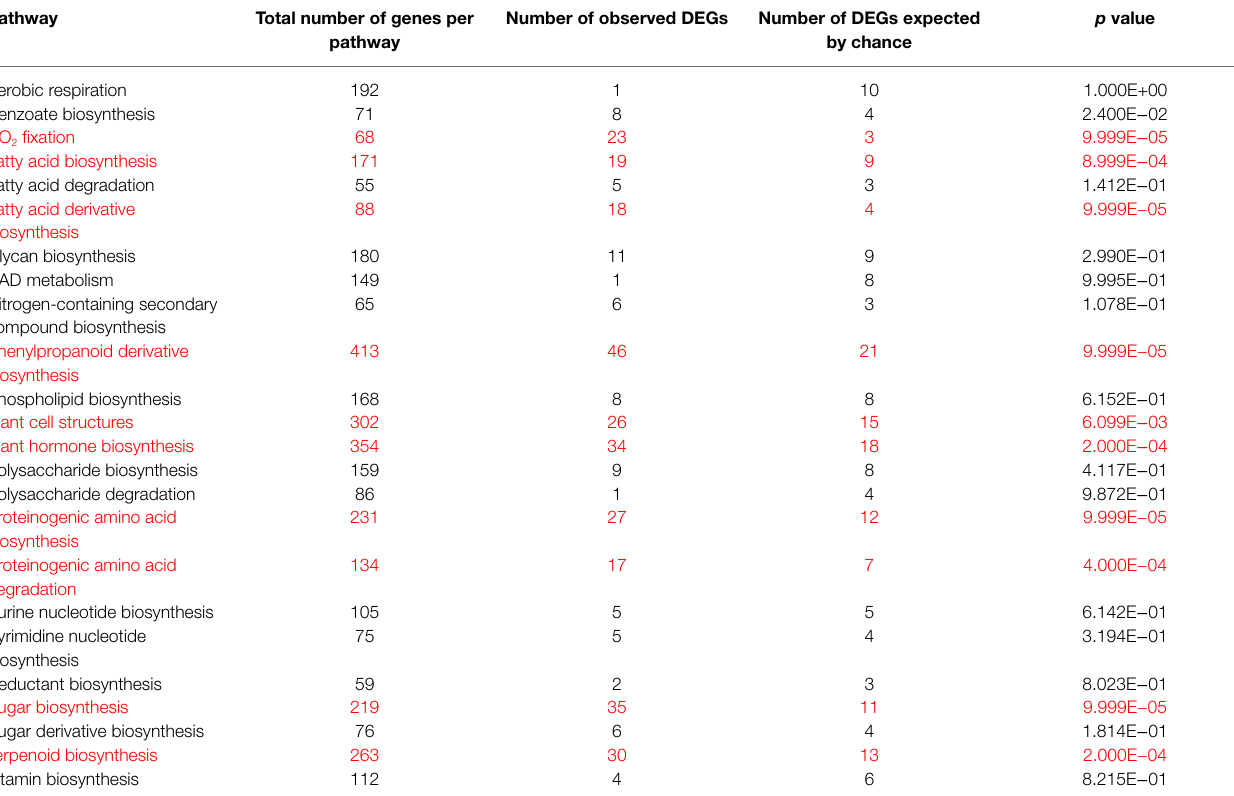
Pathways with values of p less than 0.01 are highlighted in